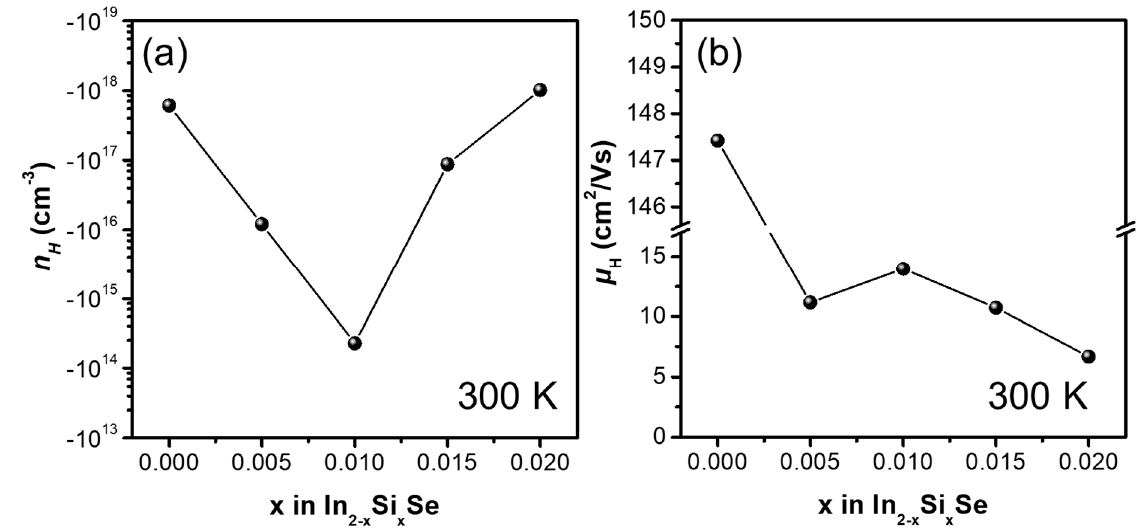
Figure 3. ( a ) Hall carrier concentration and ( b ) Hall mobility for the In 2 − x Si x Se 3 ( x = 0, 0.005, 0.01, 0.015, and 0.02) samples as a function of x .